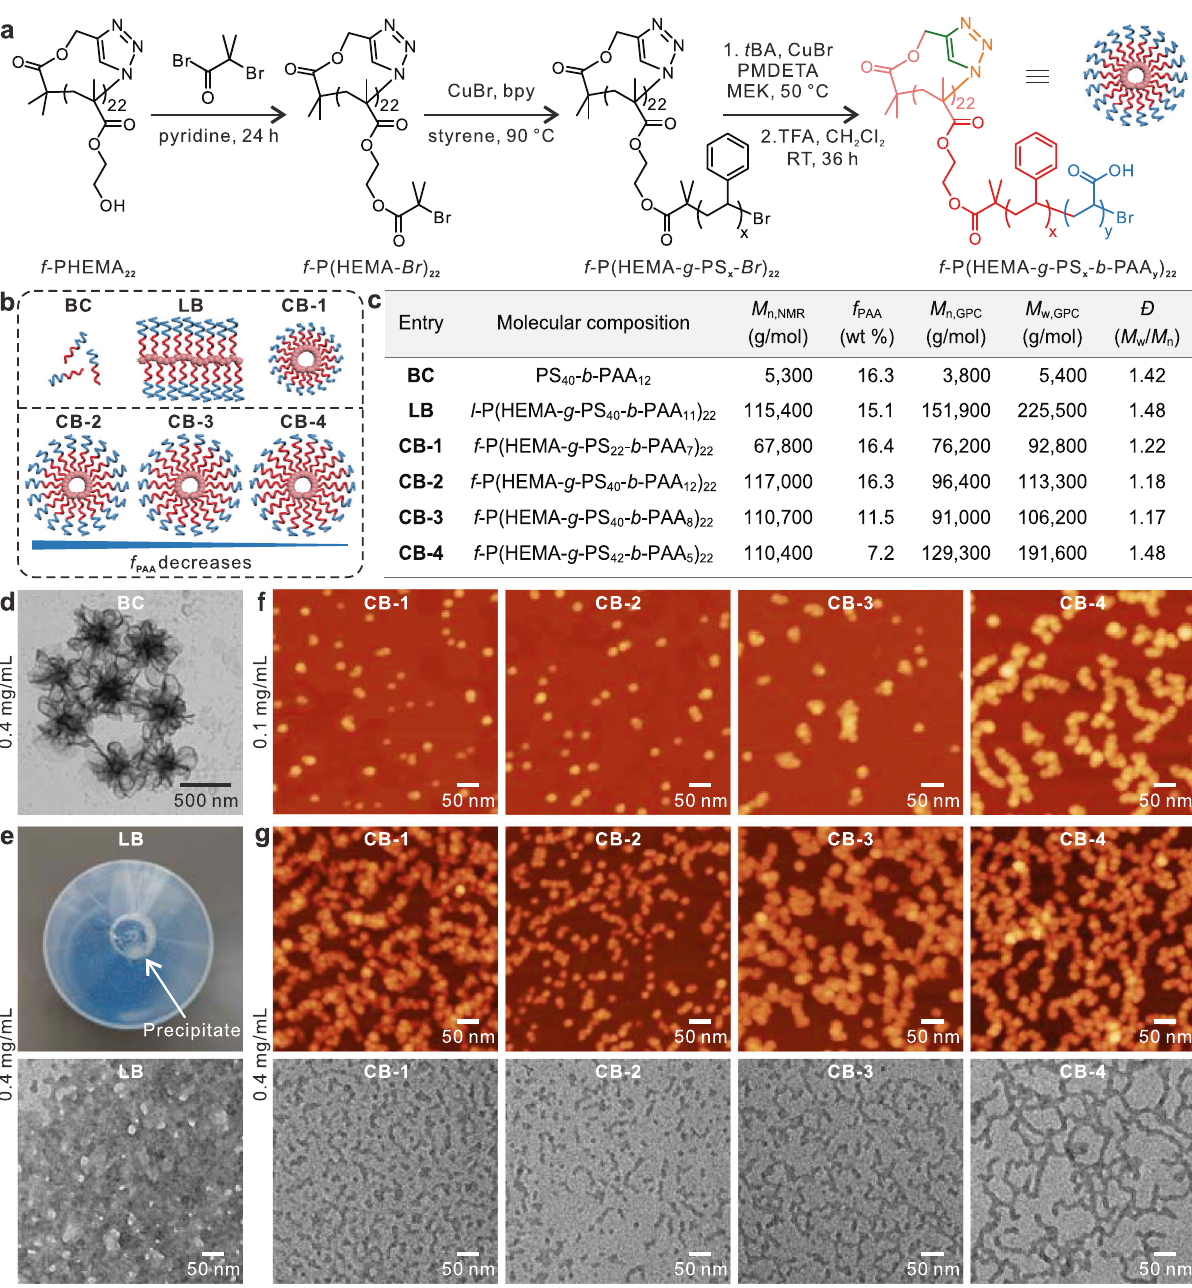
Fig. 3 Hierarchical self-assembly of cyclic brush polymers. a Scheme for the synthesis of cyclic brush polymers f -P(HEMA- g -PS x - b -PAA y ) n . b Schematic illustration, and c molecular parameters of block copolymer BC , linear brush polymer LB , and four cyclic brush polymers ( CB-1 to CB-4 ). d TEM image showing the self-assembly of BC at 0.4 mg mL − 1 in water. e Optical (top) and TEM (bottom) images showing the aggregation of LB in water. f AFM images showing the self-assembly of CB-1 to CB-4 at 0.1 mg mL − 1 in water. g AFM (top) and TEM (bottom) images showing the self-assembly of cyclic brush polymers into 1D wormlike assemblies and hierarchical structures at 0.4 mg mL − 1 in